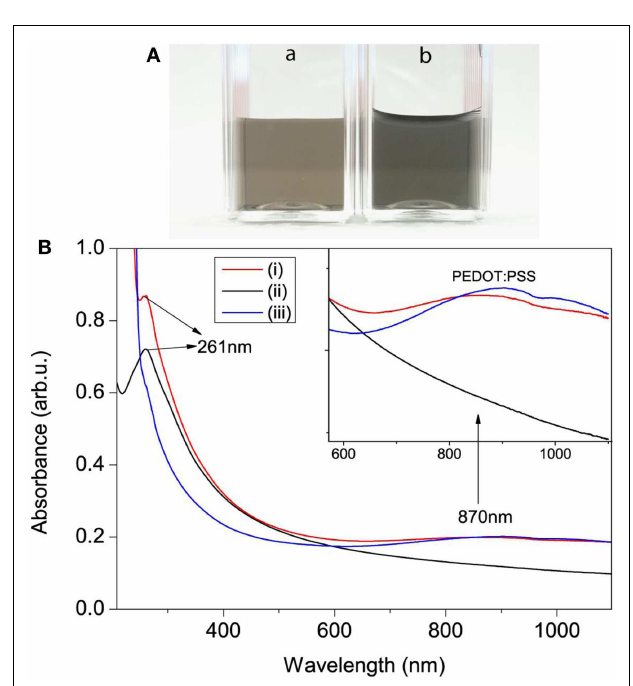
FIGURE 2 | (A) Photographs of (a) po-Gr and (b) po-Gr/PEDOT:PSS solutions. (B) UV–Vis spectra of (i) po-Gr/PEDOT:PSS, (ii) po-Gr, and (iii) PEDOT:PSS solutions (Inset shows enlarged view of absorption peak of